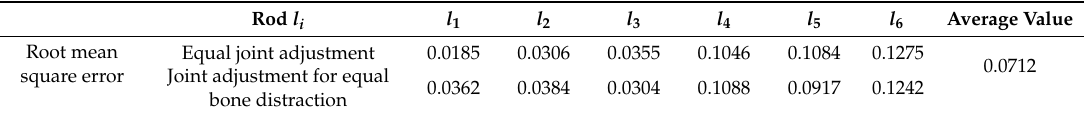
Table 2. The root mean square error of each rod.